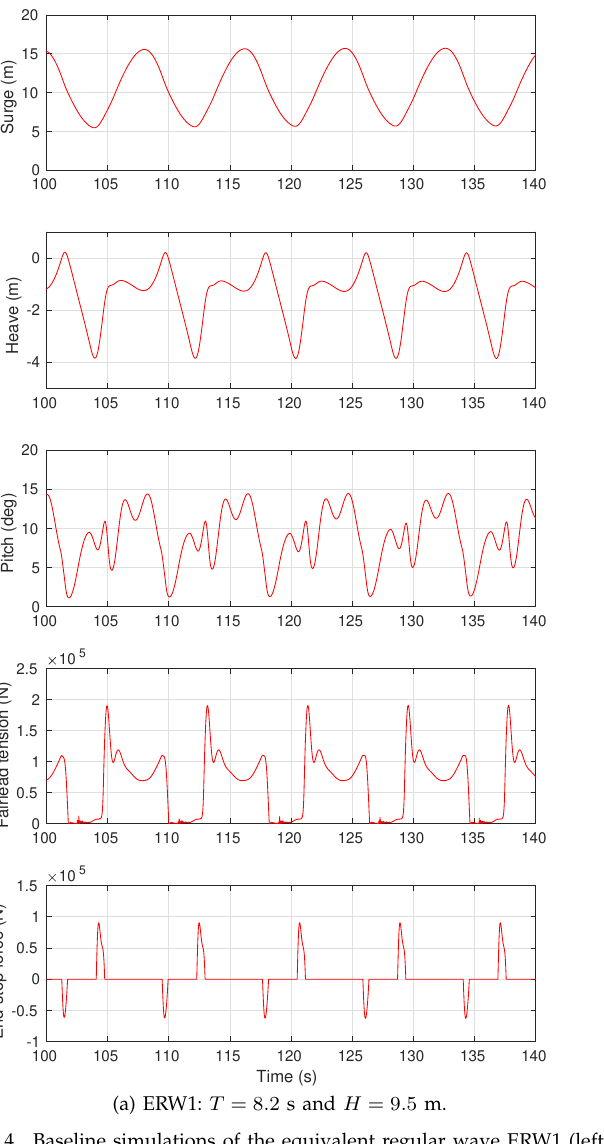
The geometry and parameter settings used in this work follow closely the settings of [29] in which ex- treme loads were investigated using CFD